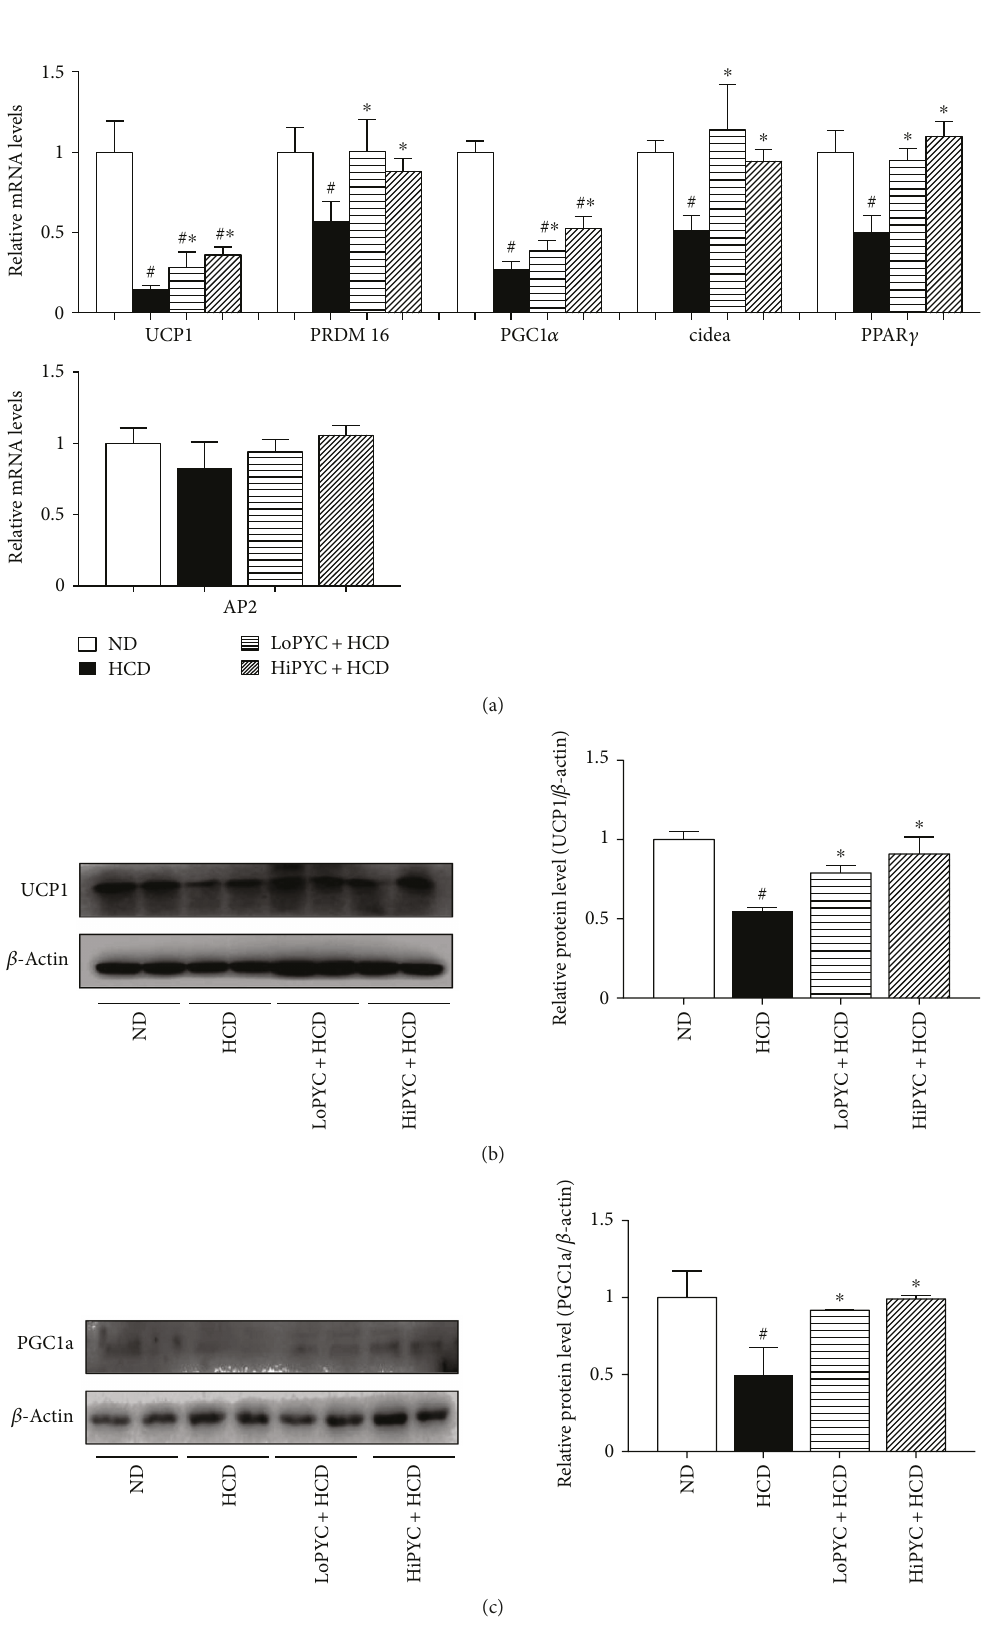
Figure 4: PYC enhanced the expression of genes and proteins related to WAT browning. (a) The expression of genes related to WAT browning and the protein levels of (b) UCP1 and (c) PGC1 α . The data are expressed as the means ± SE for 6 to 8 mice per group. # p < 0 05 versus the ND group; ∗ p < 0 05 versus the HCD